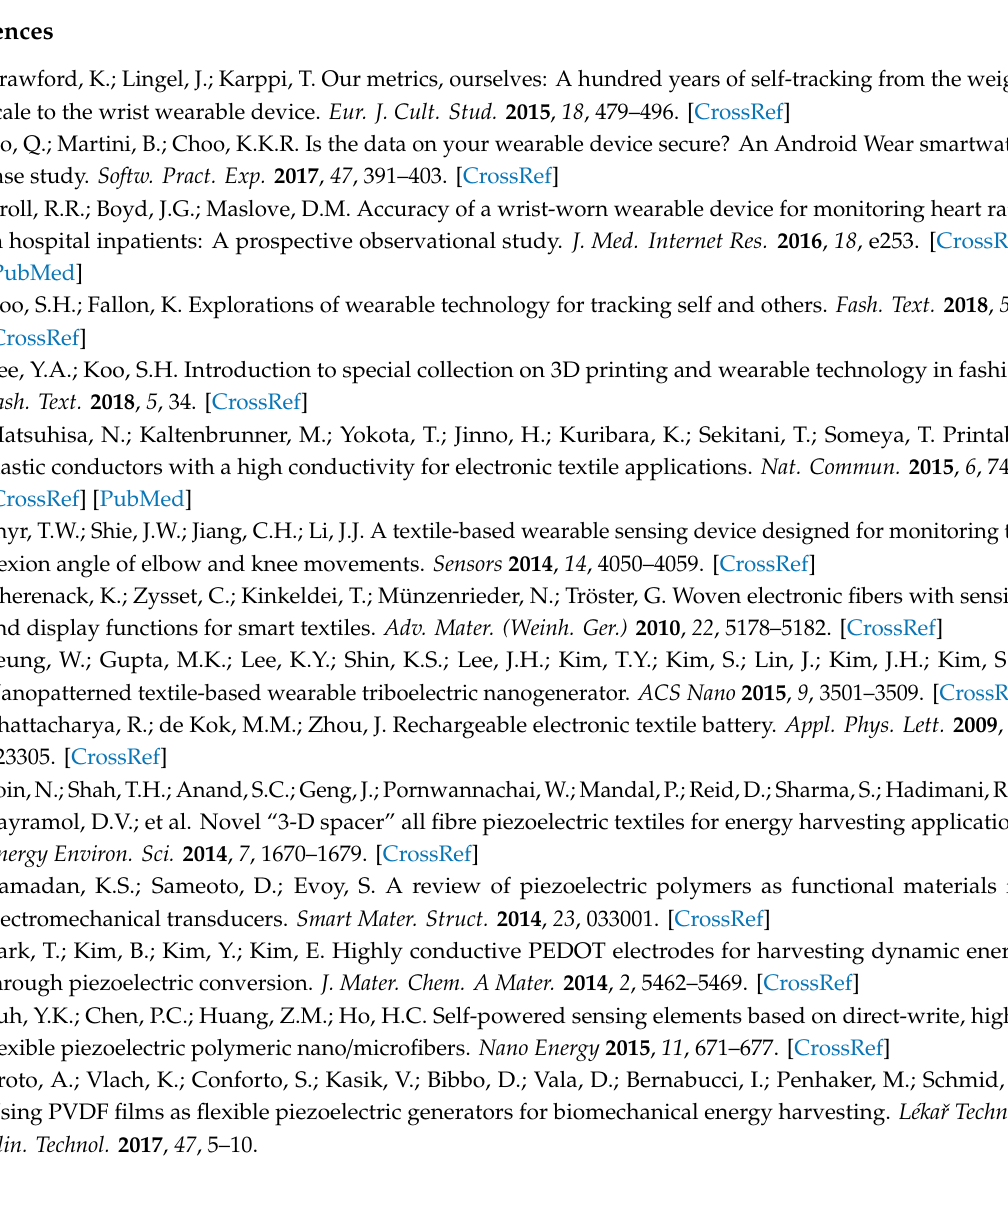
Figure A2. Changes in the add-on (%) of a sample covered by only PPy polymerization (P) and a sample treated with an NaOH solution and followed by PPy polymerization (A120P) according to the ultrasonication